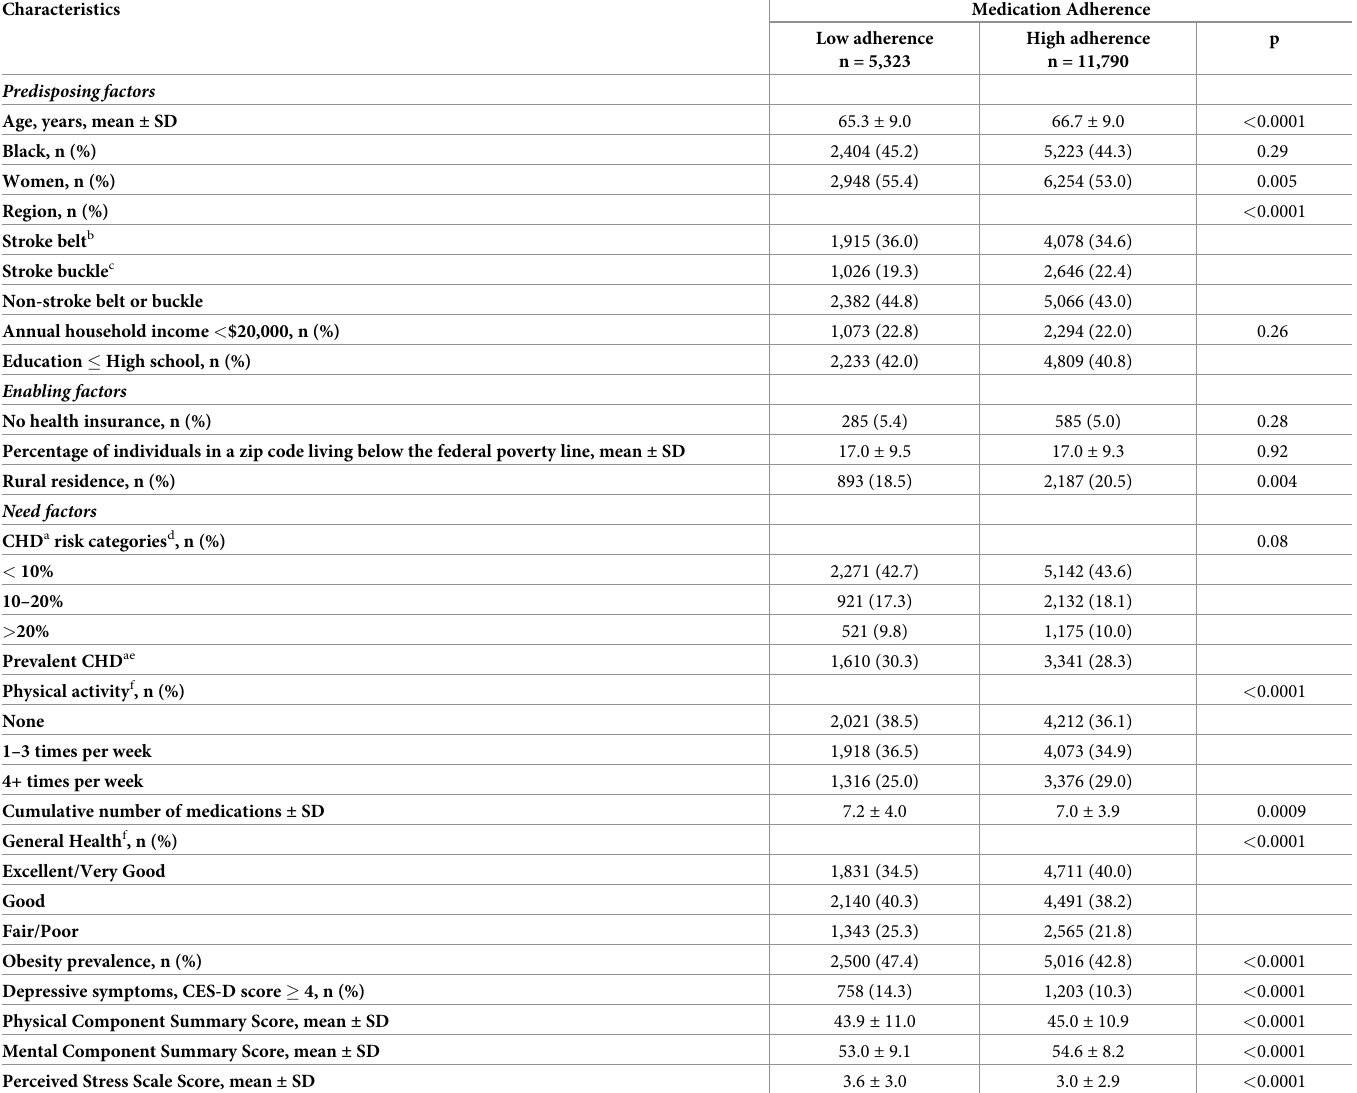
Table 1. Characteristics of REGARDS a participants by medication adherence